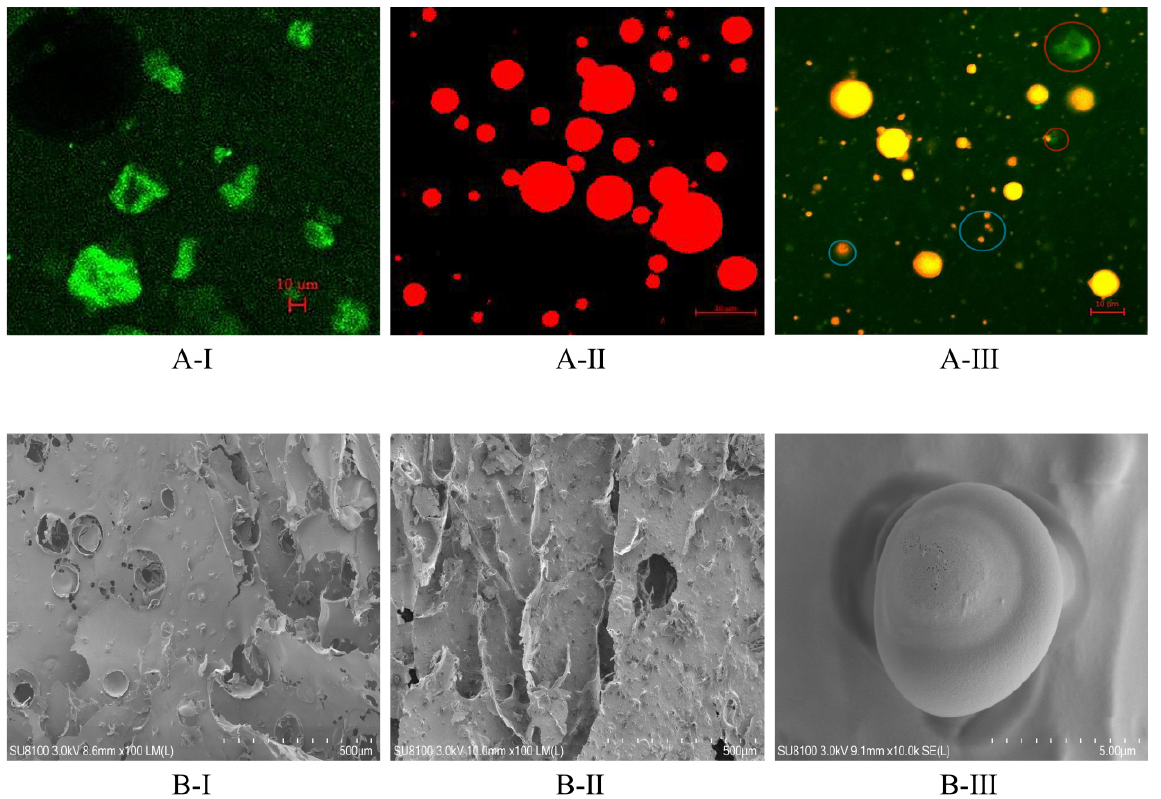
Figure 3. Confocal laser scanning microscopy images of KGM/SPI solution ( A-I ), SPI/GLO emulsion ( A-II ) and KGM/SPI/GLO emulsion (the intermediary emulsion prior to freeze-drying) ( A-III ), and scanning electron microscopy images of dried KGM/SPI wall ( × 100) ( B-I ), GLOM ( × 100) ( B-II ) and GLOM ( × 10 k) ( B-III ).